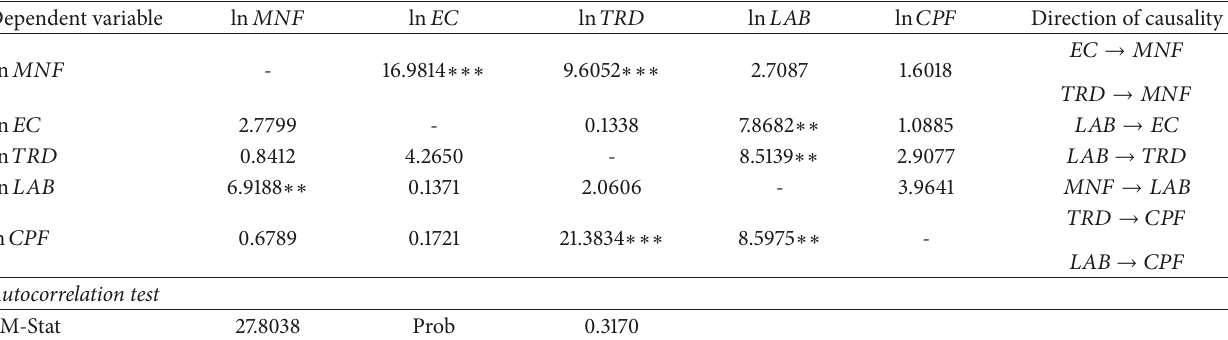
Table 7: Toda-Yamamoto causality